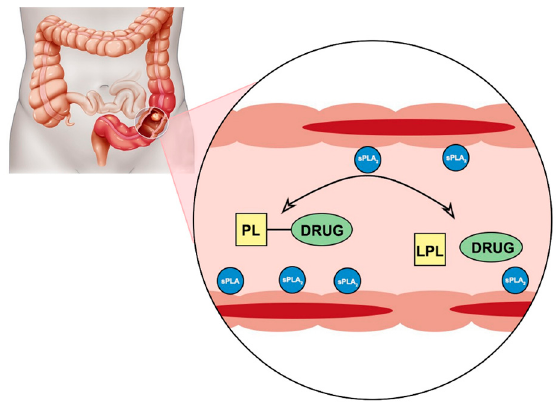
Figure 1. Illustration of colon-targeted drug delivery with phospholipid (PL)-drug conjugates; prodrug is activated by the enzyme sPLA 2 , overexpressed in the inflamed intestinal tissues of IBD patients. sPLA 2 , secreted phospholipase A 2 ; IBD, inflammatory bowel disease.